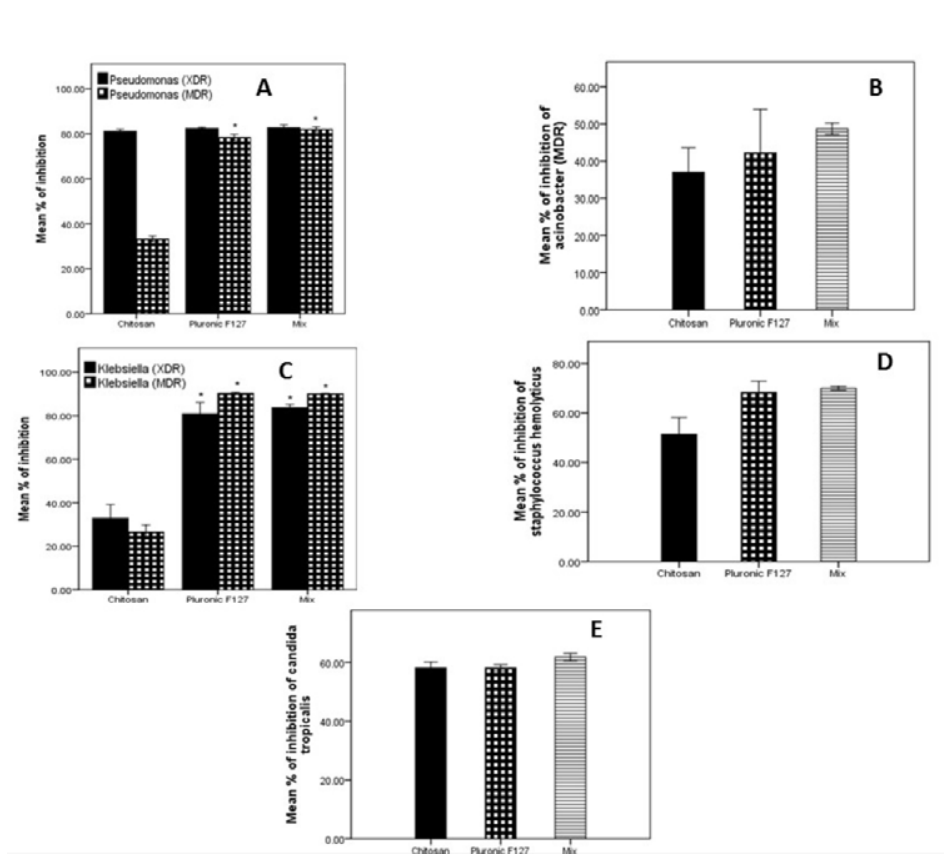
Fig. 2. Effect of Chitosan and Pluronic F127 on biofilm formation on (a) multi drug resistant Pseudomonas aeruginosa (MDR) and extensive drug resistant Pseudomonas aeruginosa (XDR) (b) Staphylococcus haemolyticus (c) multi drug resistant Klebsiella pneumoniae (MDR) and extensive drug resistant Klebsiella pneumoniae (XDR) (d) extensive drug resistant Acinetobacter baumannii (e) Candida tropicalis Table 1. Distribution of Nosocomial bacteria isolated from different clinical samples Organism Number Isolation specimen Urine Sputum endotracheal Blood secretion